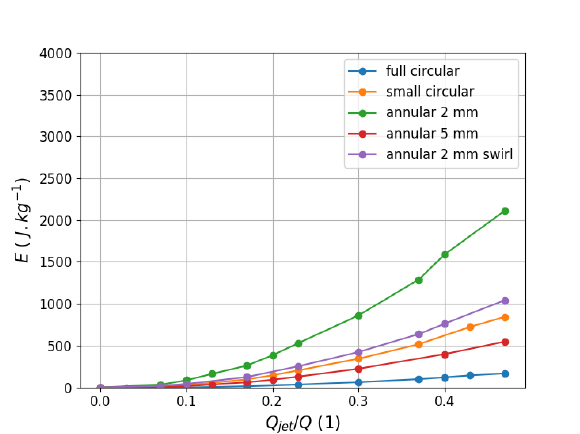
Fig. 14. Energy required for water jet supply for different methods of vortex rope